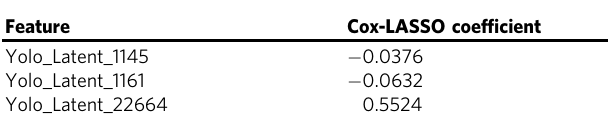
Table 3 DL (Yolo) risk score model for prognosis and the associated DL